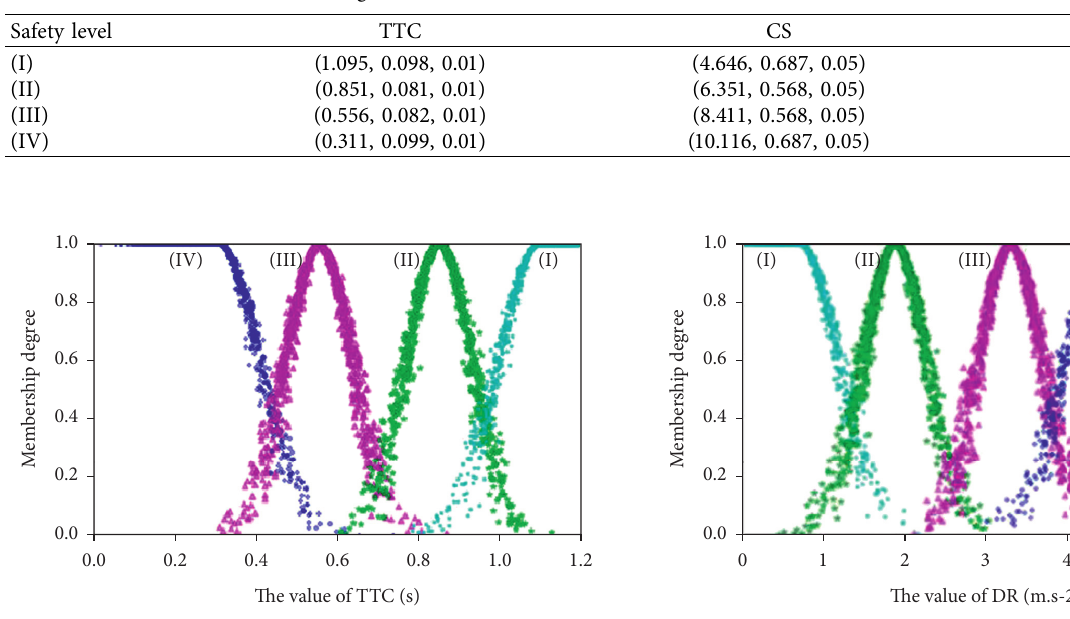
Figure 8: Cloud model for the